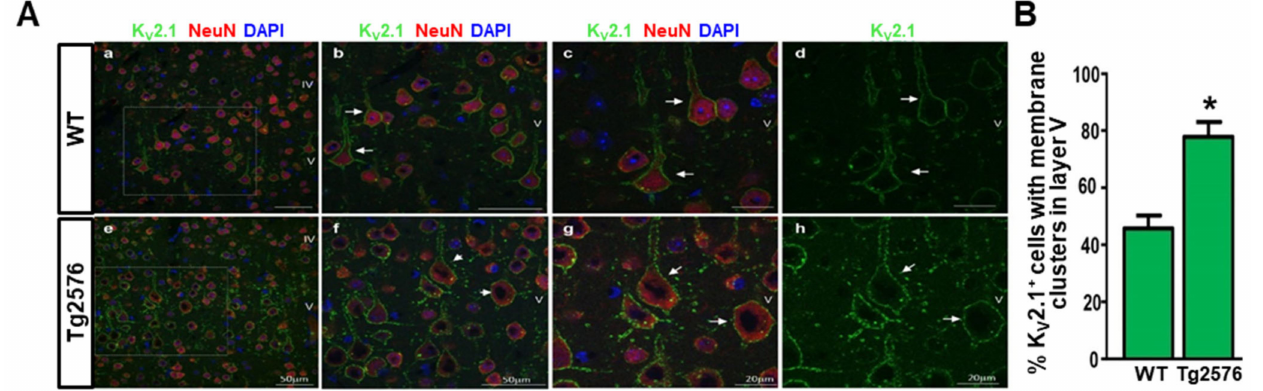
Figure 6. Analysis of K V 2.1 clustering in the layers IV–V of the somatosensory cortex of 3-month-old WT and Tg2576 mice. ( A ) Representative confocal double immunofluorescence images displaying K V 2.1 (green), NeuN (red), and DAPI (blue) distribution in the layers IV–V of the somatosensory cortex of WT ( a – d ) and Tg2576 ( e – h ) mice. b and f : higher magnification images of the frames depicted in panel a and e , respectively. c , d and g , h : higher magnification images of K V 2.1-positive neurons depicted by arrows in panels b and f , respectively. Scale bars in a , b , e , f : 50 µ m; in c , d , g , h : 20 µ m. ( B ) Quantification of K V 2.1 positive neurons with plasma membrane clusters in the layer V of the somatosensory cortex of WT and Tg2576 mice. Data were normalized to the total number of neuronal cells. * p < 0.001 vs.